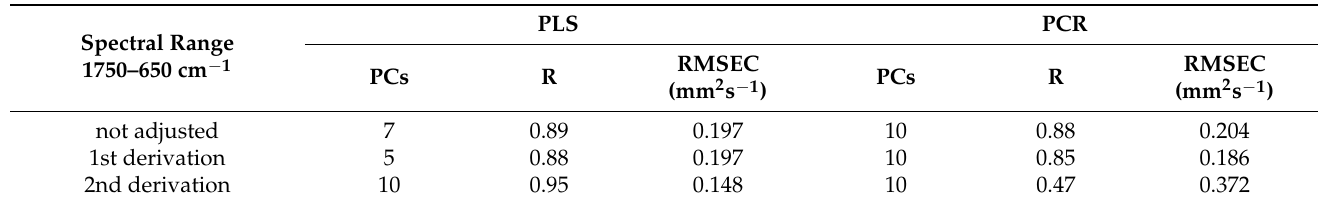
Table 1. Results of FTIR-PLS/PCR regression models for kinematic viscosity prediction at 100 °C. Spectral Range